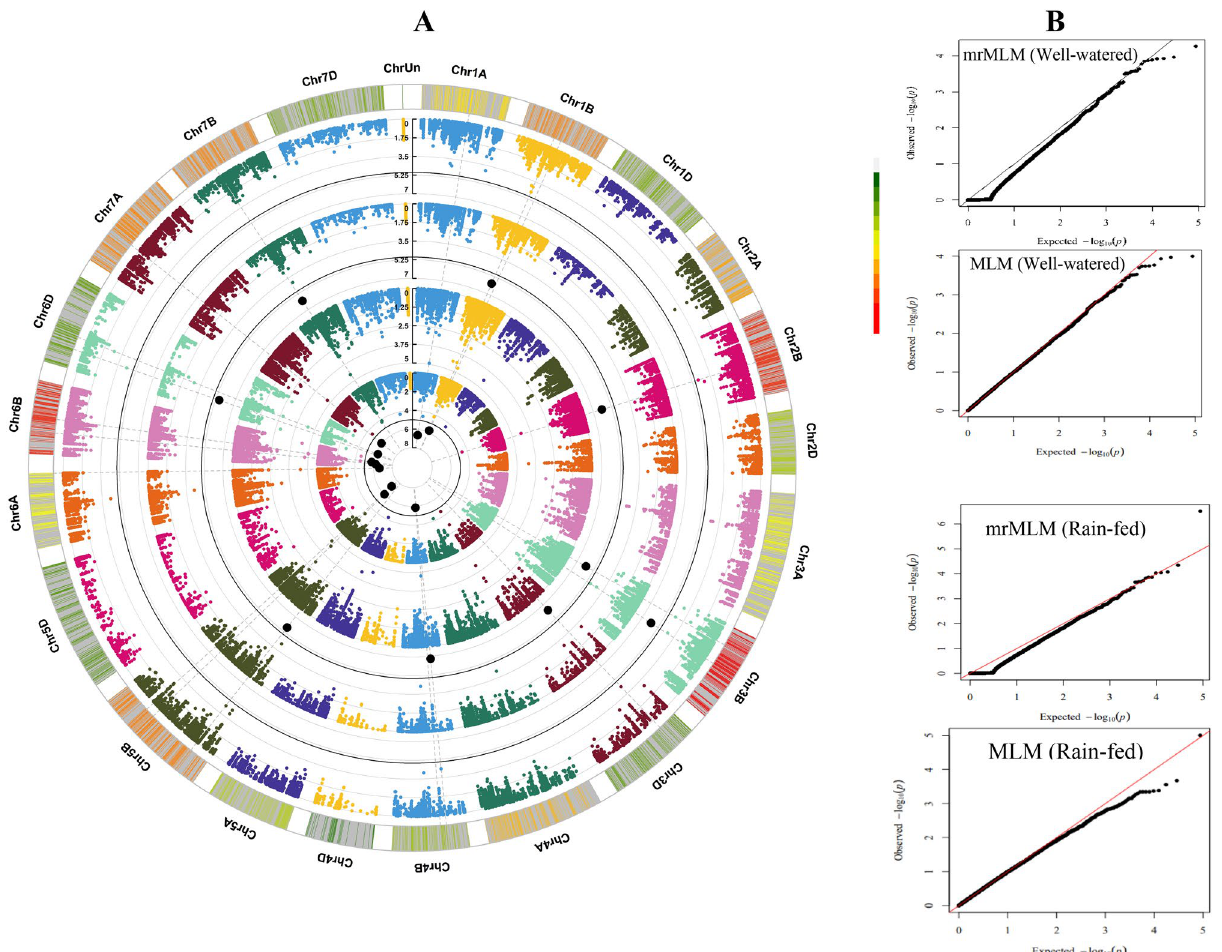
Figure 6. Circular Manhattan ( A ) and QQ-plots ( B ) to draw common regions associated with TKW in Iranian wheat landraces and cultivars. Inner to outer circles represents average trait for the mrMLM and MLM methods in the well-watered and rain-fed environments, respectively. The chromosomes are plotted at the outmost circle where thin dotted blue and red lines indicate significant levels at P -value < 0.00001 (0.05/m, Bonferroni), respectively. Black dots indicate genome-wide significantly associated SNPs at P -value < 0.00001 (0.05/m, Bonferroni)), probability levels. The scale between ChrUn and Chr1A indicates − log10 (p) values. Colored boxes outside on the top right side indicate SNP density across the genome where green to red indicates less dense to